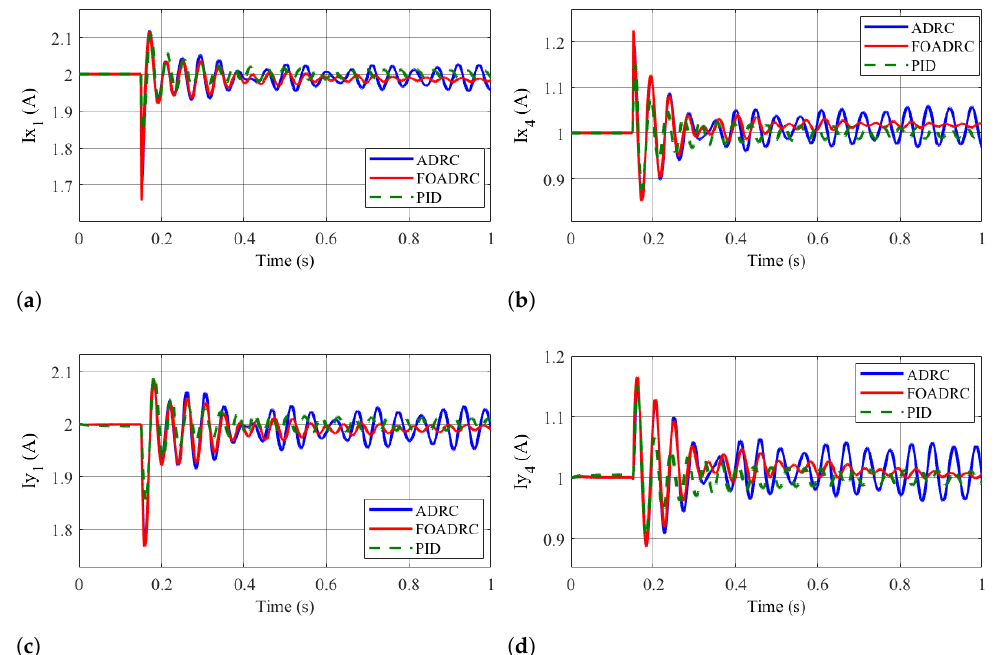
Figure 10. Control currents of the upper coils ( a , c ) and the lower coils ( b , d